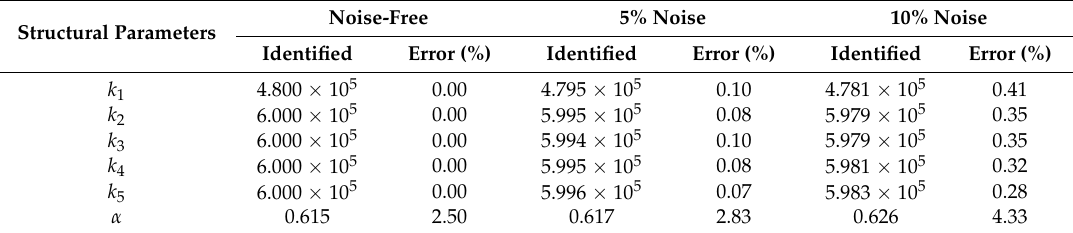
Table 1. Identified structural parameters under different noise